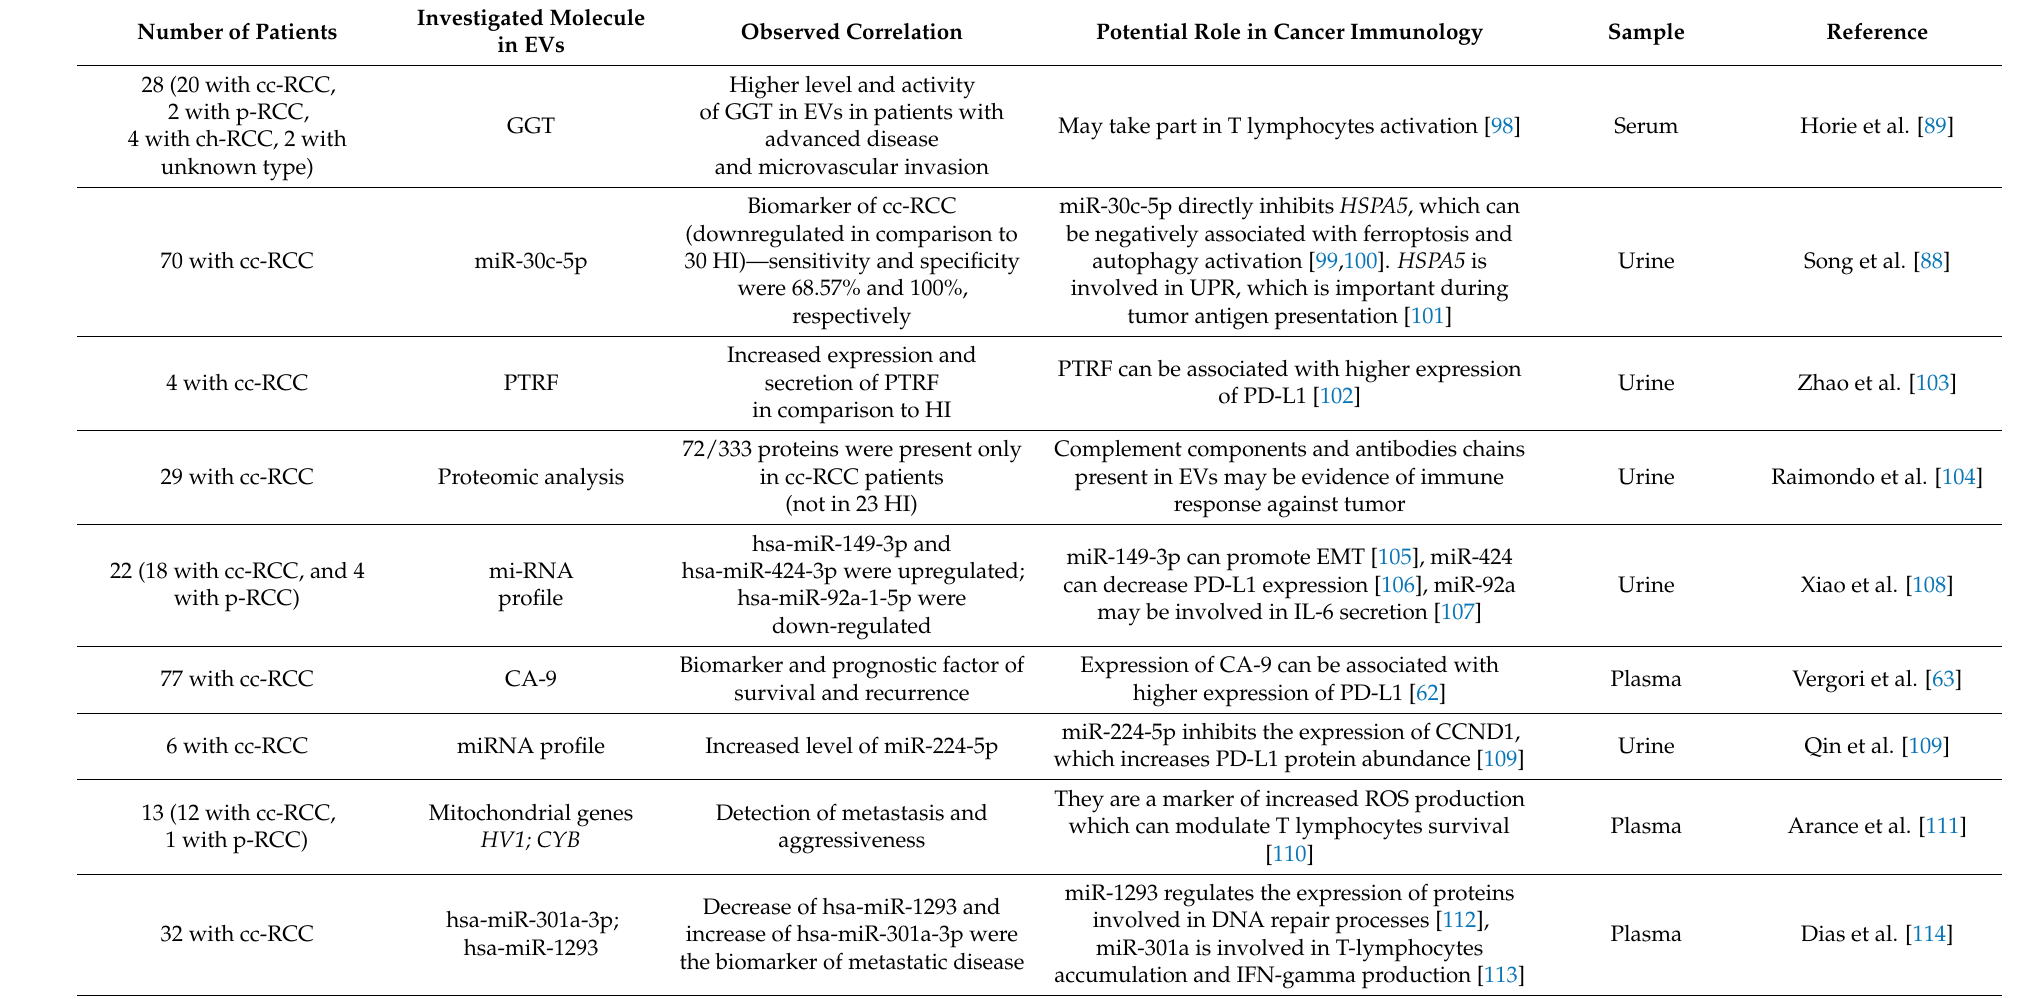
Table 1. List of selected studies focused on EVs as biomarkers or prognostic factors with a description of their potential impact on the immune